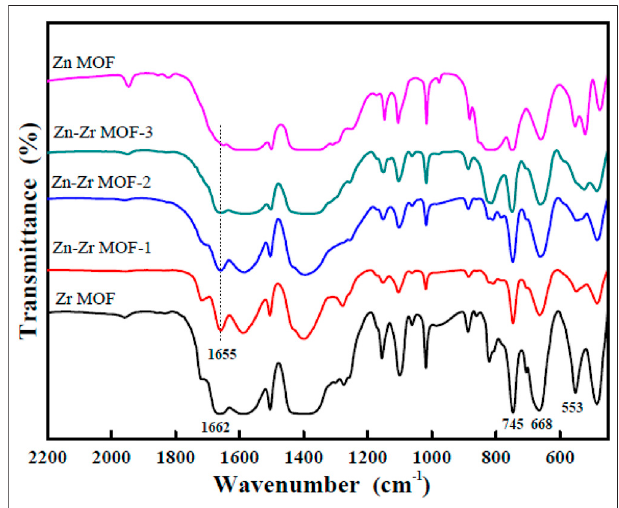
FIGURE 1 | FTIR spectra of Zr MOF, Zn MOF, and Zn-Zr MOFs with different Zn:Zr molar